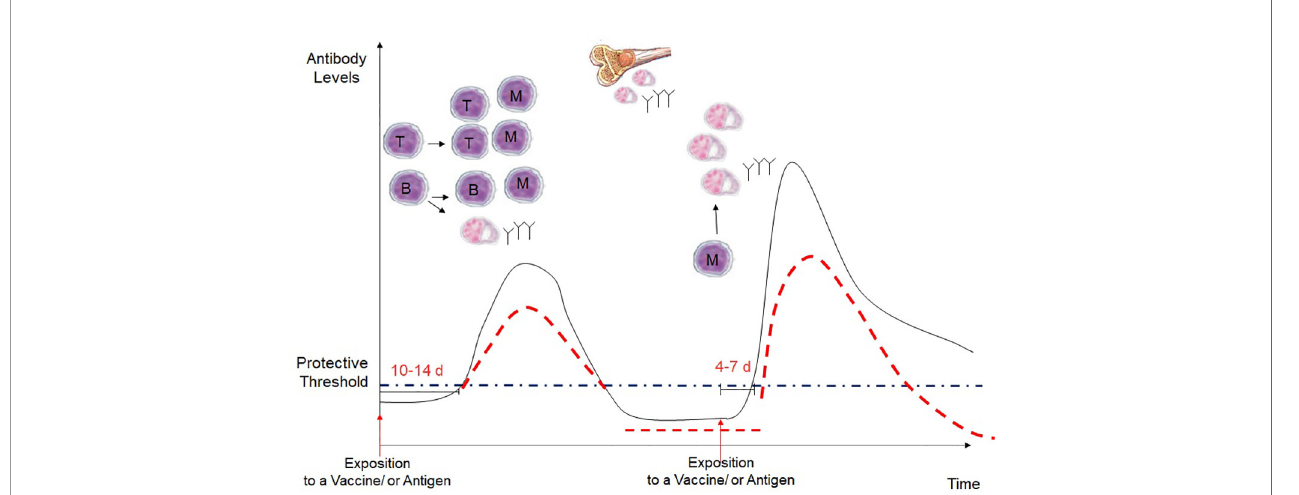
FIGURE 1 | Kinetics of the antibody response in a primary and secondary immune response. Following a fi rst exposure with an antigen, there is an interval of 10-14 days before the production of IgG antibodies, which occurs after the interaction of naive B and T cells, which become effector cells and develop into gentiane ́ e- speci fi c memory B cells, short-lived plasma cells and long-lived plsame cells. Then, long-lived plasma cells in migrate in the bone marrow and continue to secrete IgG antibodies. However, with the time the antibodies decrease often under the protective levels. During a secondary exposure with the vaccine or the antigen, memory B and T cells are rapidly reactivated, with a more rapid and higher IgG increase that usually last longer. However, in immunosuppressed children, the peak of the antibody response is expected to be lower, and the antibodies are expected to decrease more rapidly after